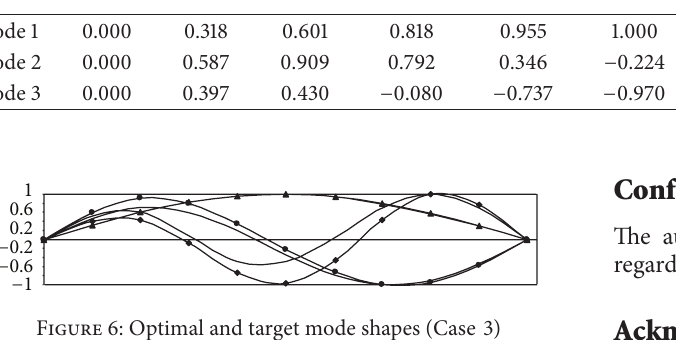
Table 18: Optimal mode shapes (Case 3).